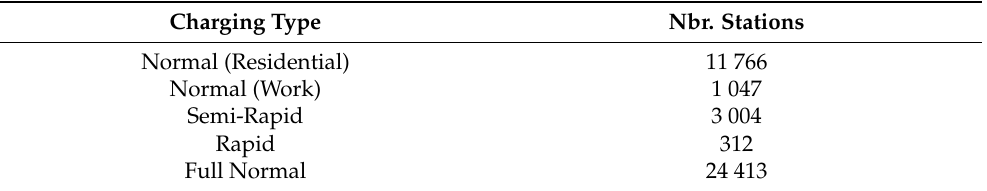
Table 6. Number of charging points needed to cover the total